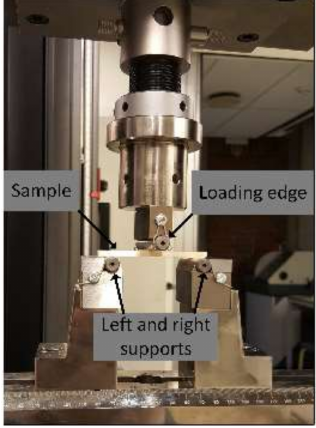
Figure 3. Experimental setup for flexural